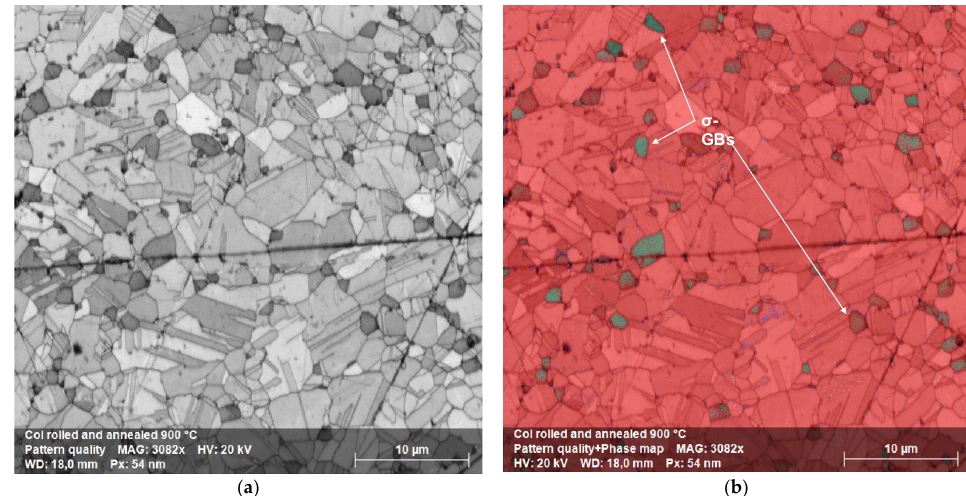
Figure 14. ( a ) Cross-sectional image of a sample cold-rolled and annealed for 100 h at 1173 K. ( b ) Corresponding EBSD map, with FCC matrix in red and precipitates in green.